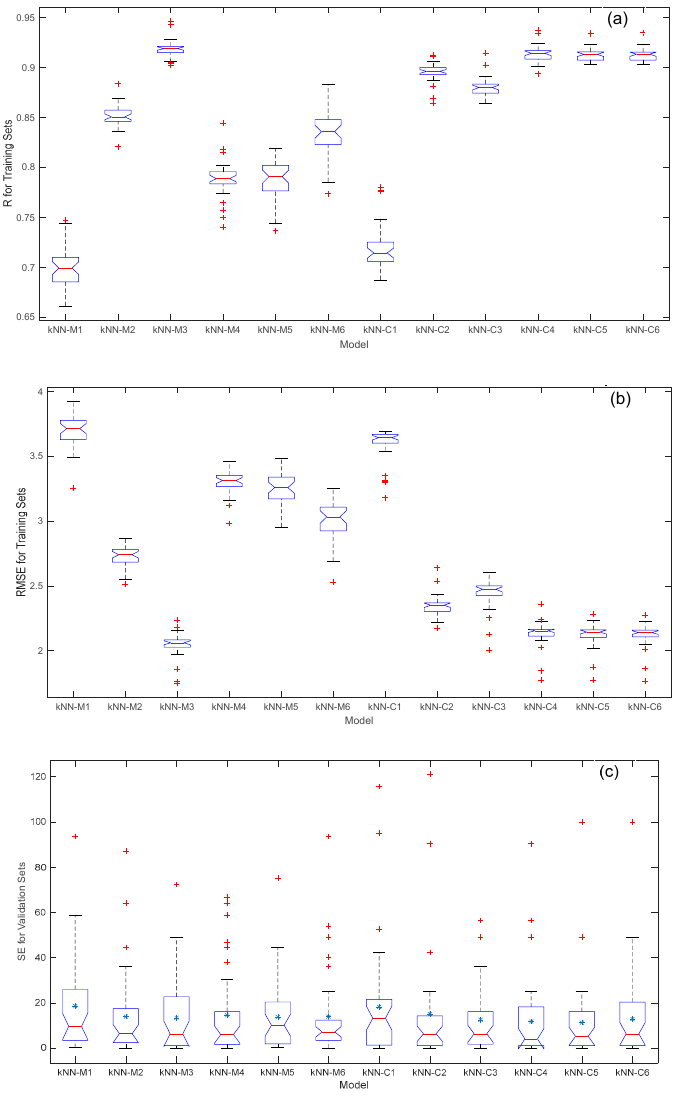
Figure 4. Performance of selected kNN models. ( a ) R for training sets. ( b ) RMSE for training sets. ( c ) SE for validation sets.